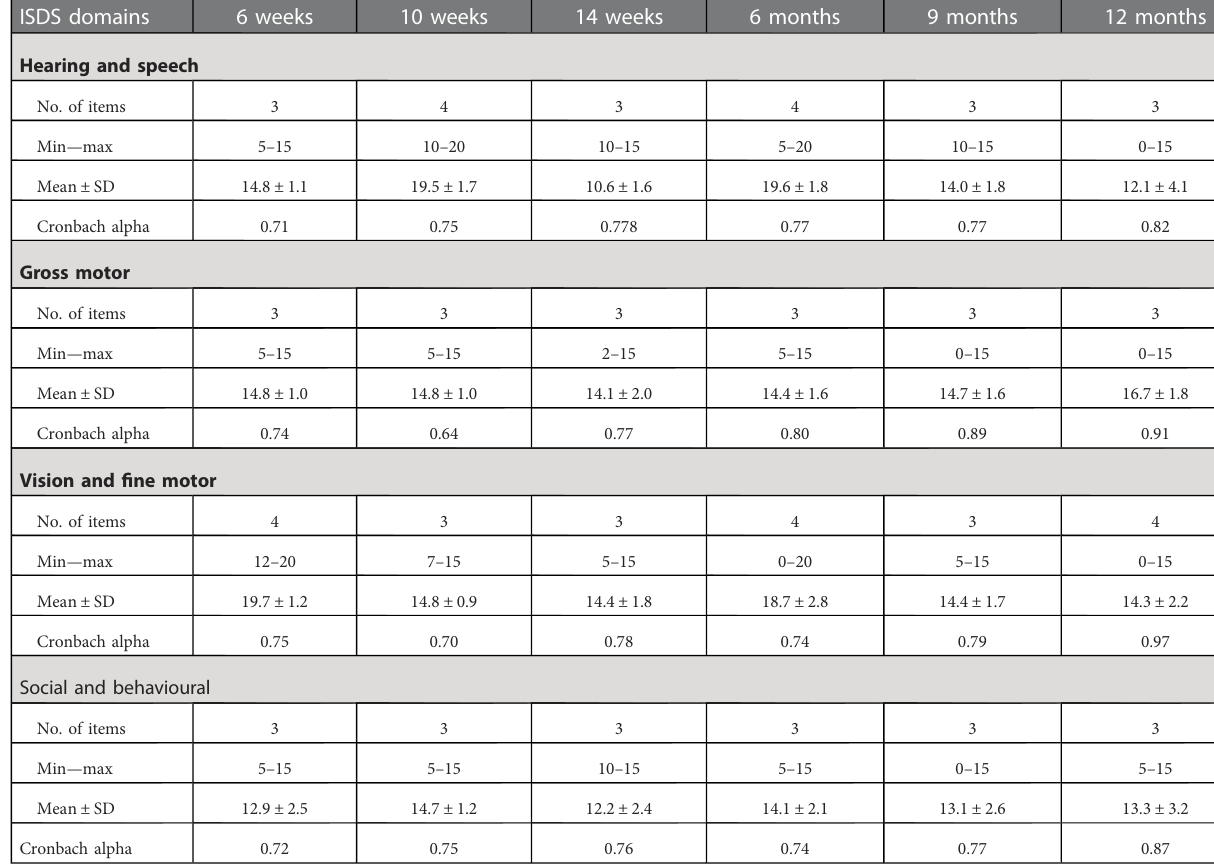
TABLE 2 Summary Statistics of Scores and Internal Consistency of the ISDS Scales by Domains and Ages. ISDS